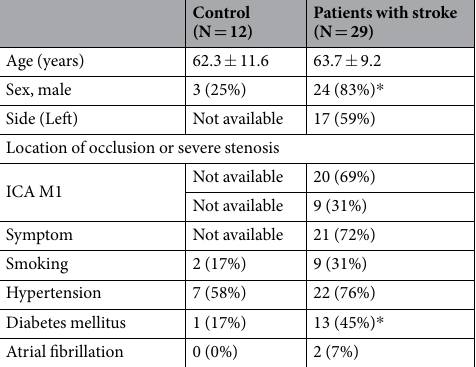
Table 1. Characteristics of the study participants. As a control for the NIRS/ICG measures, preoperative and asymptomatic patients who were scheduled to undergo craniotomy for their unruptured cerebral aneurysms were selected. These patients had neither a history of cerebral strokes nor stenosis of more than 50% on the preoperative MR angiography. Values are given as an average ± standard deviation or as number (%). * Significantly different by Fisher’s exact test (P < 0.05). One patient had bilateral stenosis in the ICA. ICA, the internal carotid artery; M1, horizontal portion of the middle cerebral